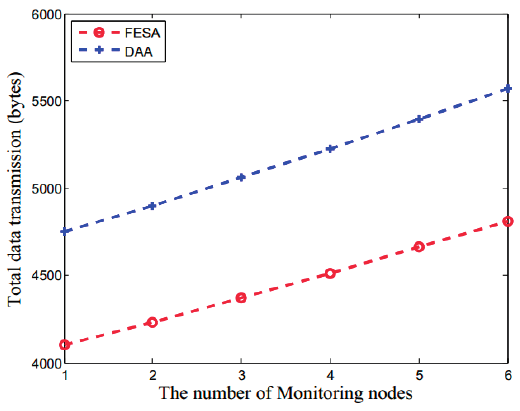
Figure 6. The impact of monitoring nodes on the communication overhead for FESA and DAA. Compared to no data aggregation protocols, the schemes using aggregators to aggregate receiving data can effectively reduce the data redundancy.